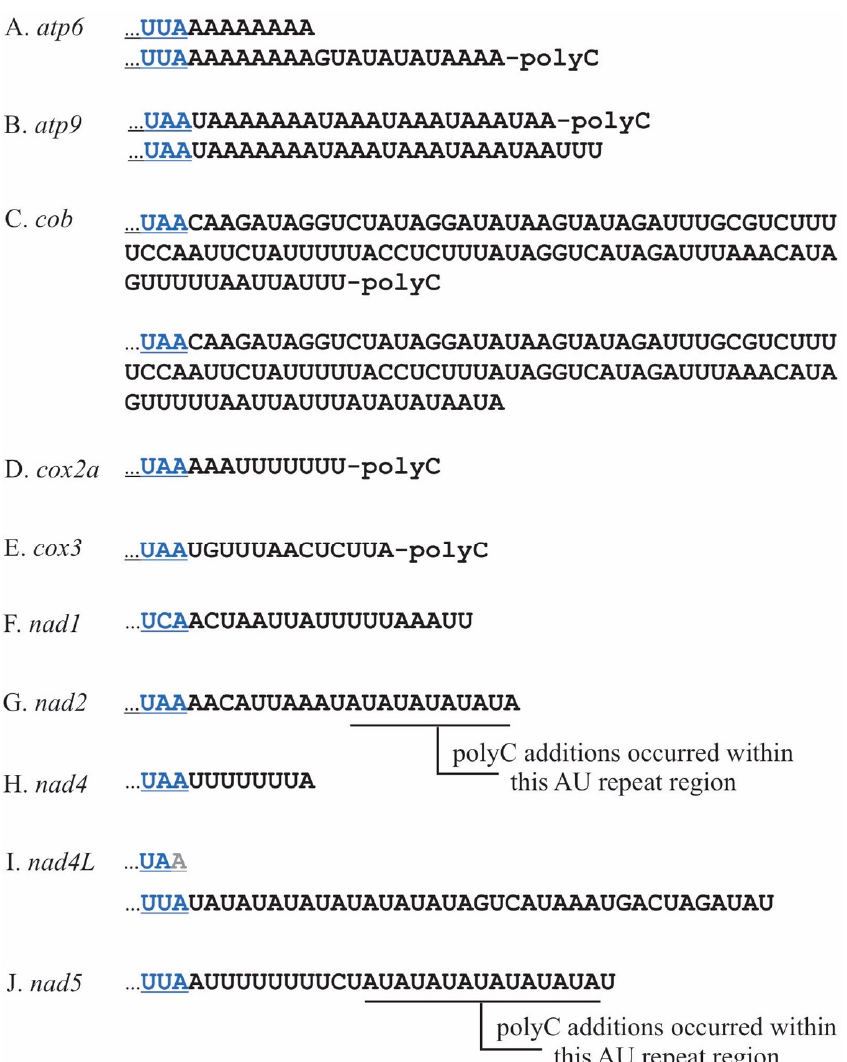
Figure 2. The 3 ′ termini and UTRs of ten P. duplex mitochondrial mRNAs. Stop codons are blue. ( A ). Two 3 ′ termini were detected for atp6 . The upper (shorter) sequence had no oligonucleotide addition, while a portion of transcripts represented by the lower (longer) sequence had poly(C) additions. ( B ). For atp9 a portion of the transcripts with the upper terminus had a poly(C) addition, while the slightly longer one represented by the lower sequence did not. ( C ). For cob a portion of the transcripts with the upper terminus had a poly(C) addition, while the one represented by the longer sequence did not. ( D ). For cox2a a single terminus was detected and a portion of them had a poly(C) tail. ( E ). A single terminus, some of which had a poly(C) addition, was detected for cox3 . ( F ). A single terminus was detected for nad1 and no oligonucleotide additions were detected. ( G ). For nad2 poly(C) additions were detected at several different termini within an AU repeat region. ( H ). A single terminus was detected for nad4 and no oligonucleotide additions were detected. ( I ). A single terminus was detected for nad4L and no oligonucleotide additions were detected. ( J ). For nad5 poly(C) additions were detected at several different termini within an AU repeat region.